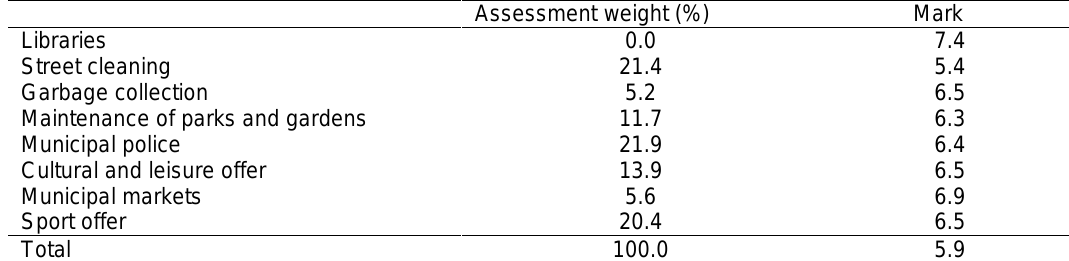
Table 5. Weight of the different services in the assessment of municipal management. Assessment weight (%)